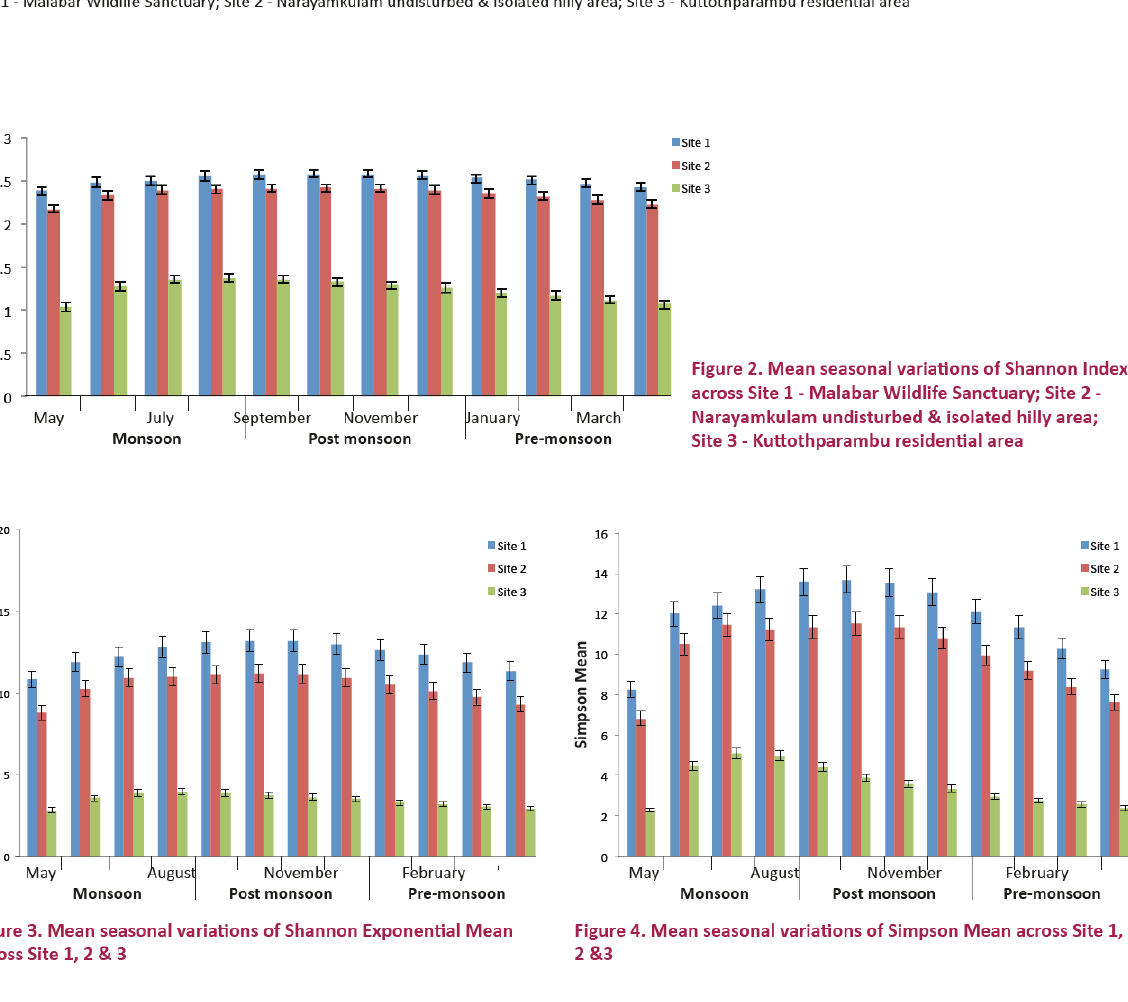
Ffigure 3. Mean seasonal varfiafions of Shannon Exponenfial Mean across Sfite 1, 2 &